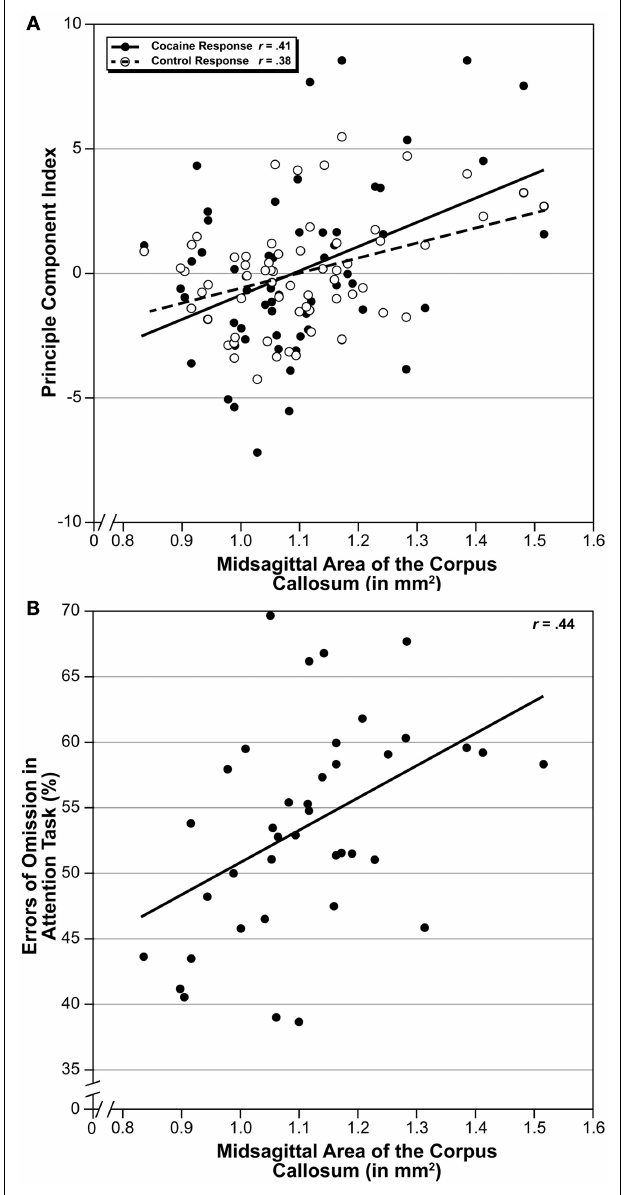
FIGURE 4 | Covariation of MSACC with behavioral traits. (A) Scatterplot of MSACC correlated with principle component comprised of 12 traits measuring locomotor response to cocaine administration (Philip et al., 2010; black circles) and four traits measuring the same response following saline administration from the same study (white circles). Solid line is linear correlation of cocaine response, and dotted line is linear correlation of saline response. (B) Scatterplot of MSACC correlated with errors of omission on a test of